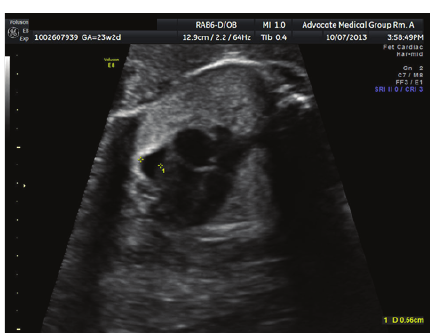
Figure 2: Fetal pericardial